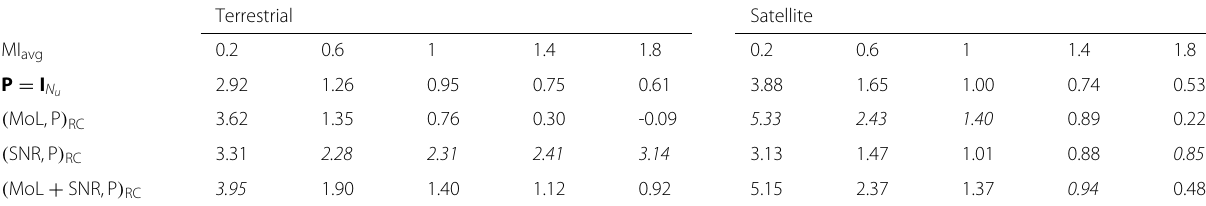
Table 9 SNR gain (dB) of the AD for 4-QAM Terrestrial